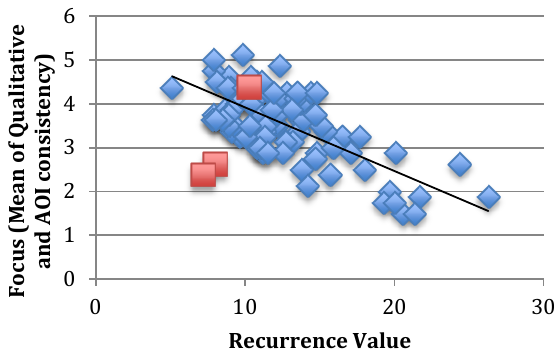
Figure 5 : Mean of the qualitative and quantitative values for attentional focus for the test images used in Farnand (2013) plotted relative to the recurrence values generated by the rqa function using the study’s fixation data as input. The two lower square data points represent the Paint Girl and Stained Glass full scenes, which are under-predicted for attentional focus by the recurrence value. The top square data point represents the closely-cropped Mason Lake scene, which is well-predicted by recurrence value, (but not by the determinism value – see Figure